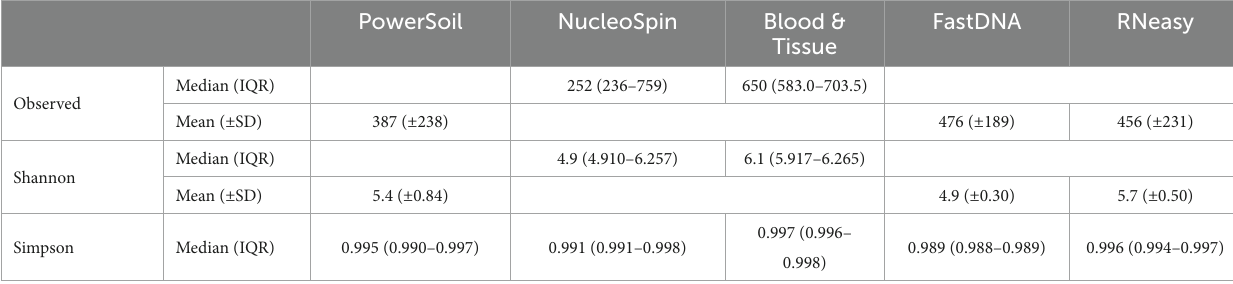
IQR, interquartile range; SD, standard